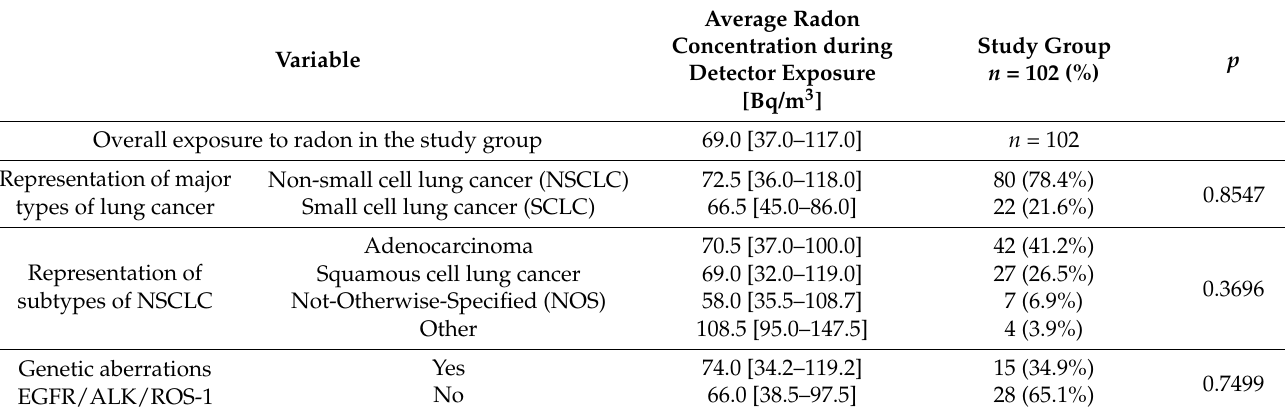
Table 3. The average radon concentration during detector exposure in a residential environment in lung cancer patients depending on selected clinical